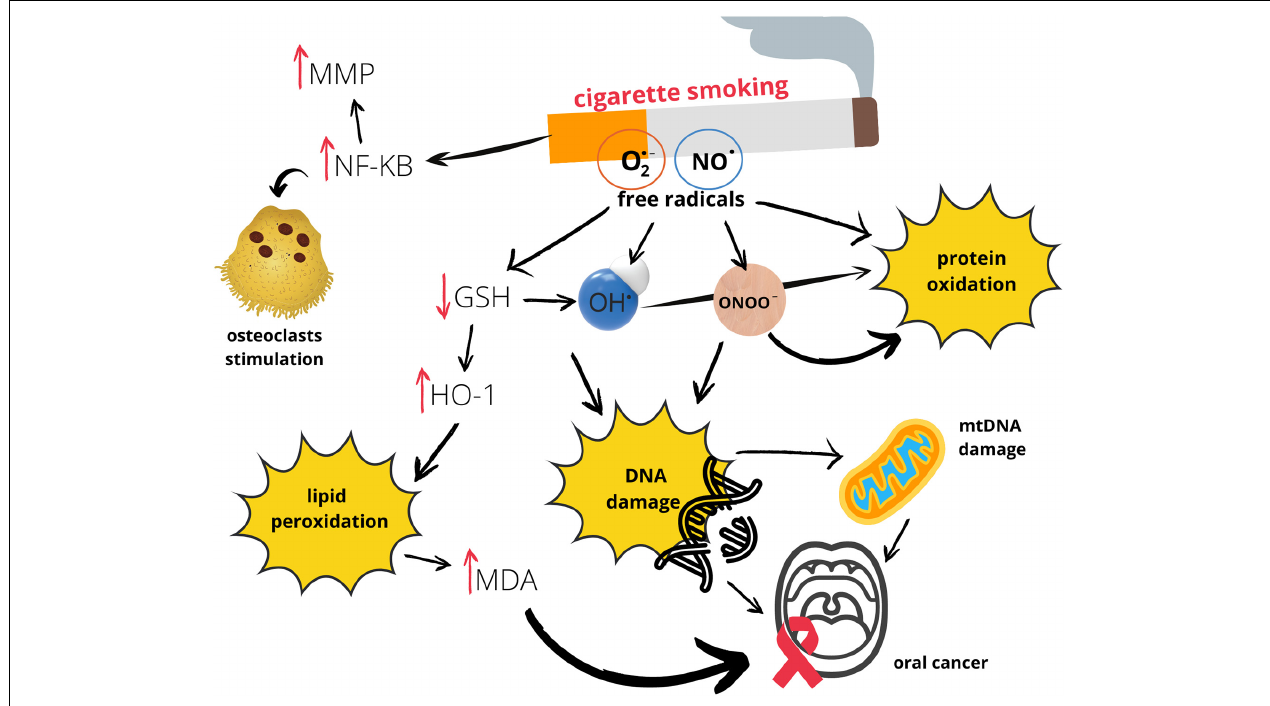
FIGURE 3 | Effects of smoking on oral redox homeostasis. GSH, glutathione; HO–1, heme oxygenase 1; MDA, malondialdehyde; MMP, metalloproteinase; mtDNA, mitochondrial DNA; NF- K B, nuclear factor kappa-light-chain-enhancer of activated B cells; NO · , nitric oxide; O 2 ·− , superoxide anion radical; OH · , hydroxyl radical; ONOO − ,